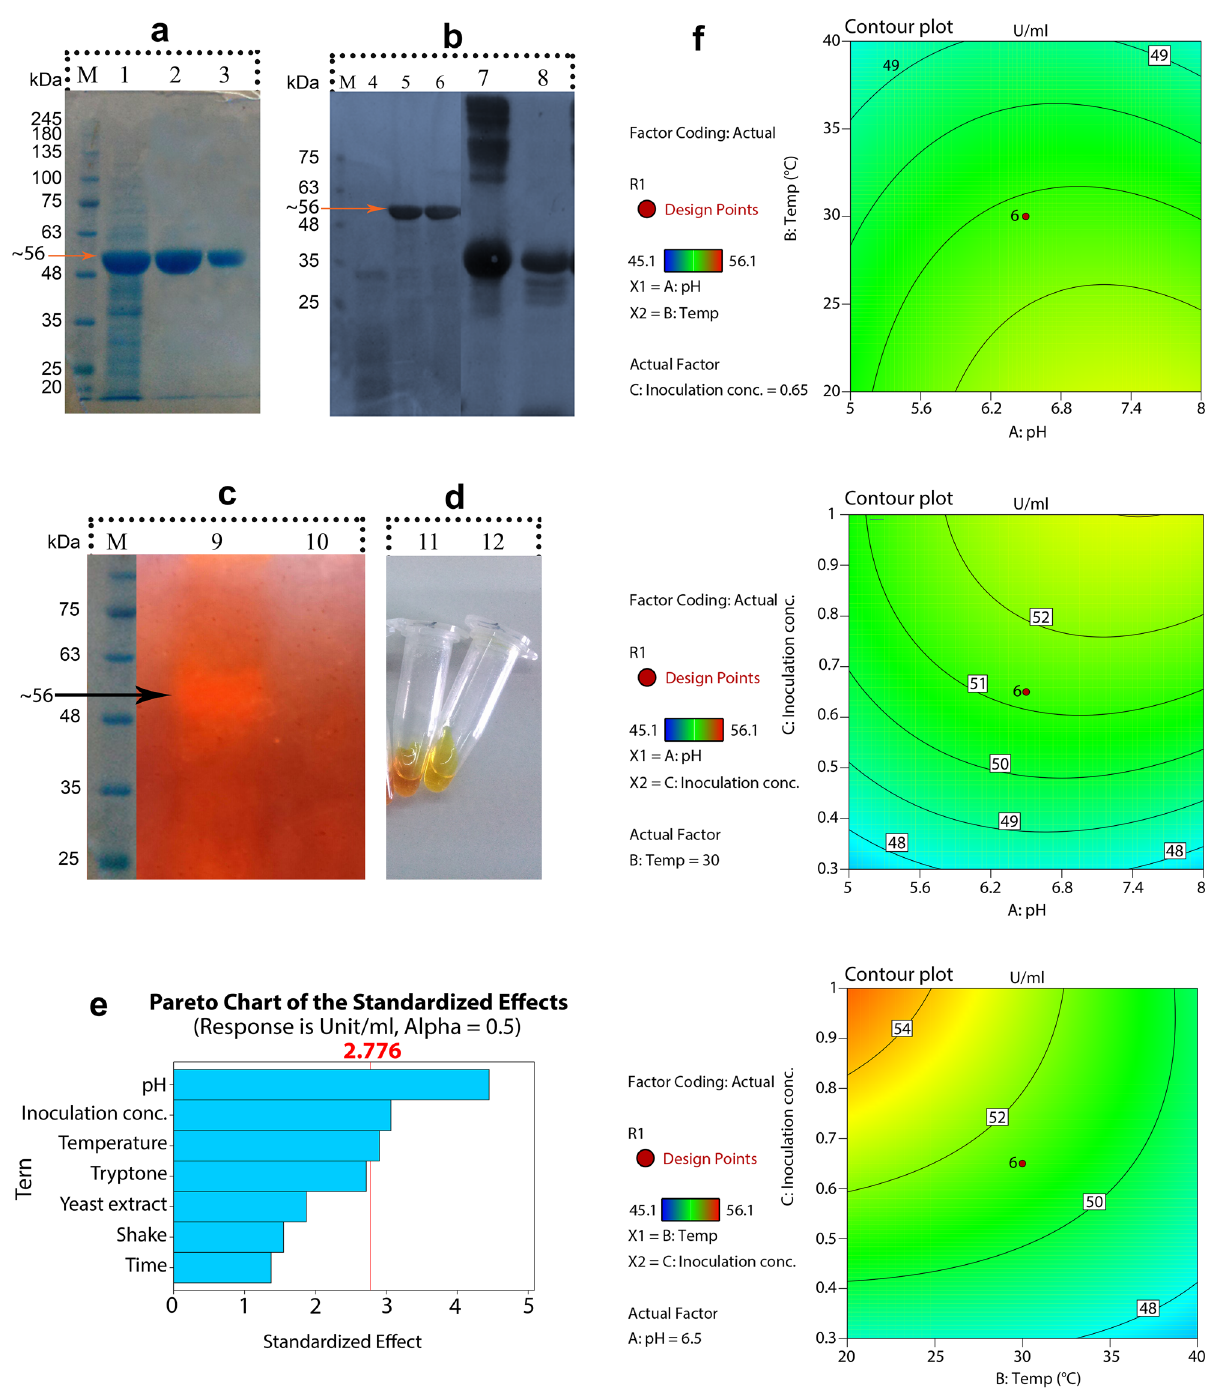
Figure 6. ( a ) M: protein marker, 1: crude extract of recombinant BL21, 2: Ni–NTA purified, 3: heat shock single-step method purified recombinant CelC307. ( b ) M: protein marker, 4: effect of proteinase K on CelC307, 5: effect of trypsin on CelC307, 6: purified recombinant CelC307, 7: BSA (positive control), 8: effect of trypsin on BSA. ( c ) M: protein marker, 9: formation of yellowish-orange halo related to the CelC307, and 10: empty pET26b(+) expressed in BL21 on the non-denatured gel. ( d ) 11: CelC307 activity assay (CMC 1% + enzyme), 12: blank control for CelC307 activity assay (CMC 1% + without enzyme). ( e ) Pareto chart of standardized effects shows the main effects of the variables, and response is cellulase activity (U/mg, α = 0.05) (obtained by Design-Expert 12). ( f ) The contour plots show the effects of variables and their interactions on cellulose activity (obtained by Design-Expert